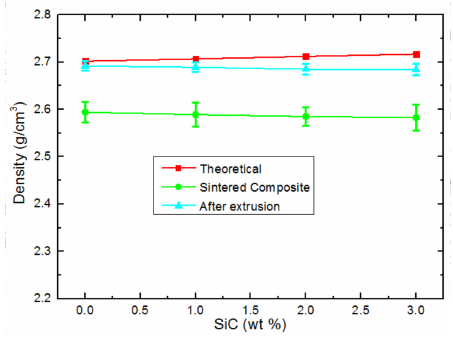
Figure 7. Comparison between experimental and theoretical density of nanocomposite samples at different weight fractions of